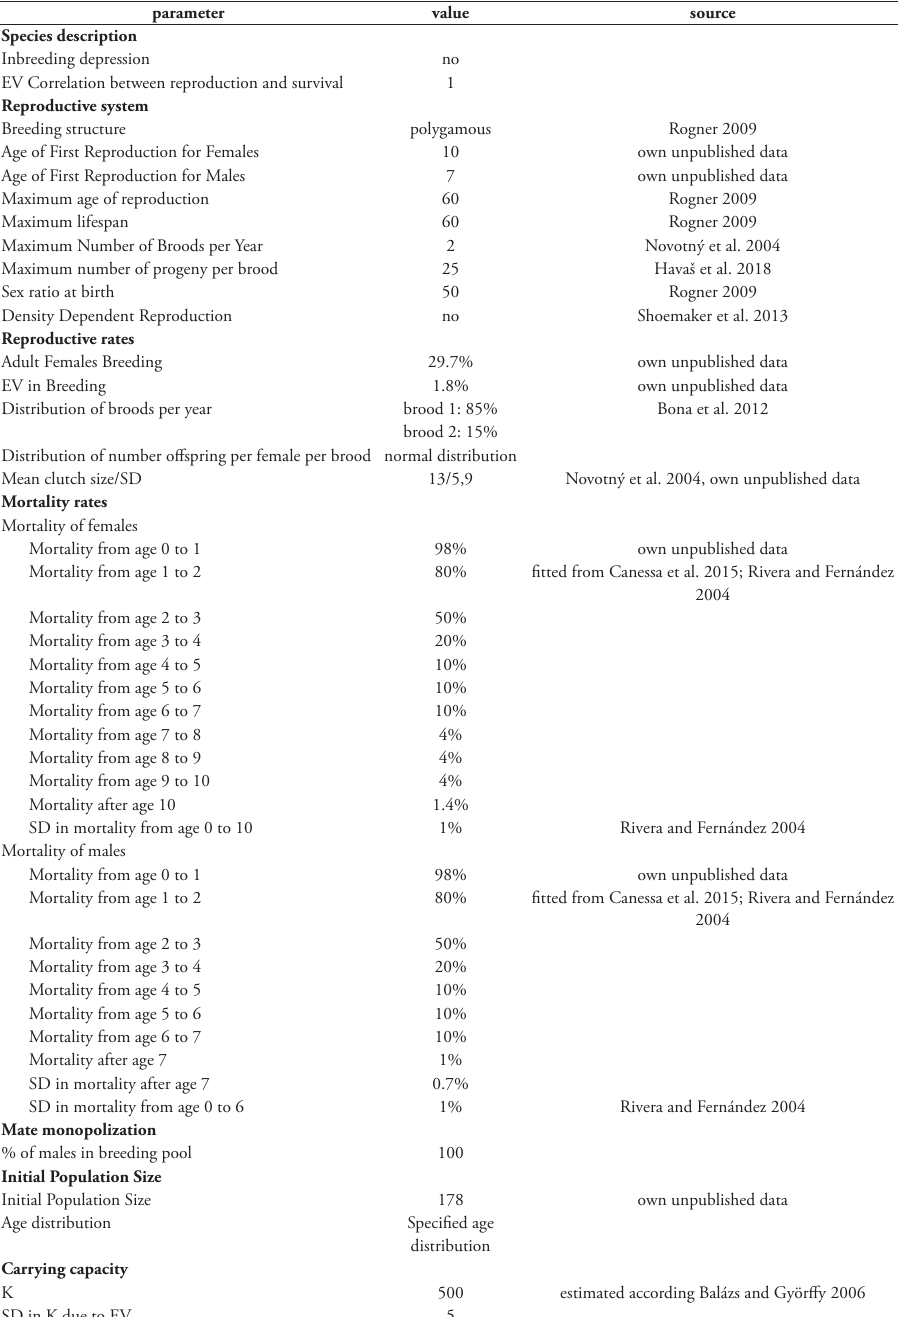
Table 1. Vortex life history parameter inputs of E. orbicularis in the Tajba NNR, employed for the base- line population viability analysis